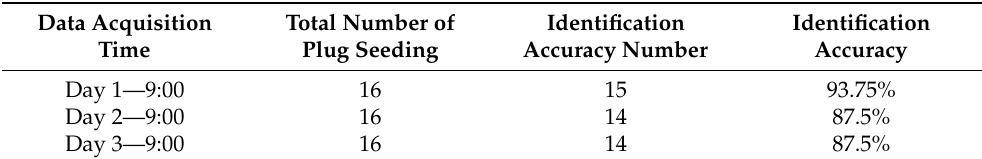
Table 4. The recognition accuracy of the plug hole.